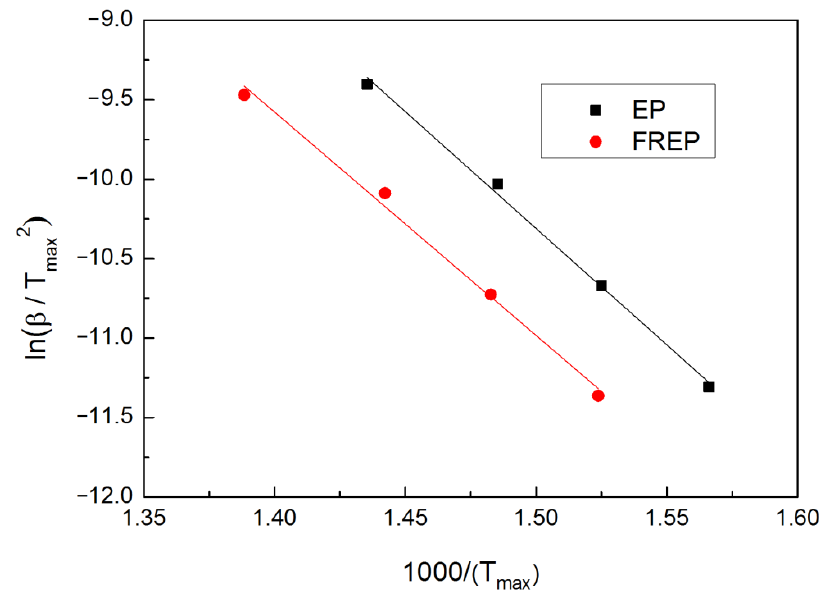
Figure 6. The curves of ln ( β / T 2 max ) vs. 1/ T max of EP and FREP. Table 2. Kinetic parameters for the degradation of EP and FREP by the Kissinger method.